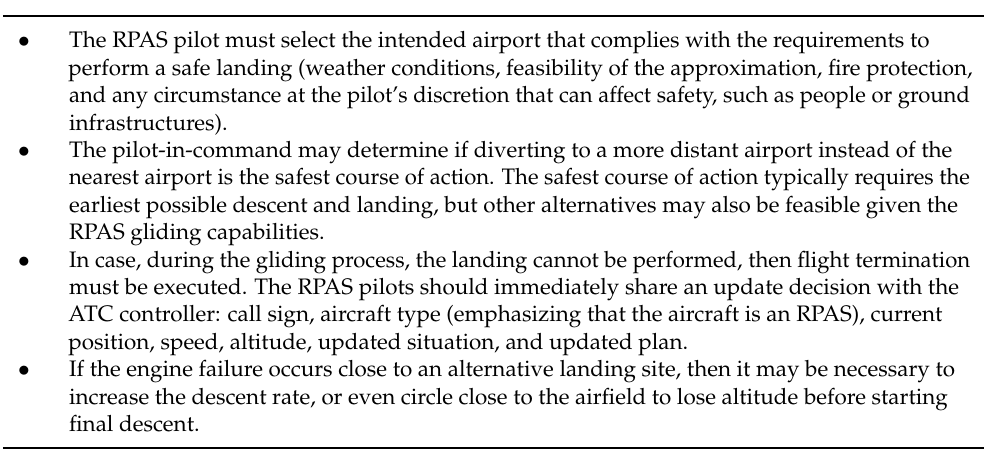
Table 3. Flight-specific procedures for urgent flight termination